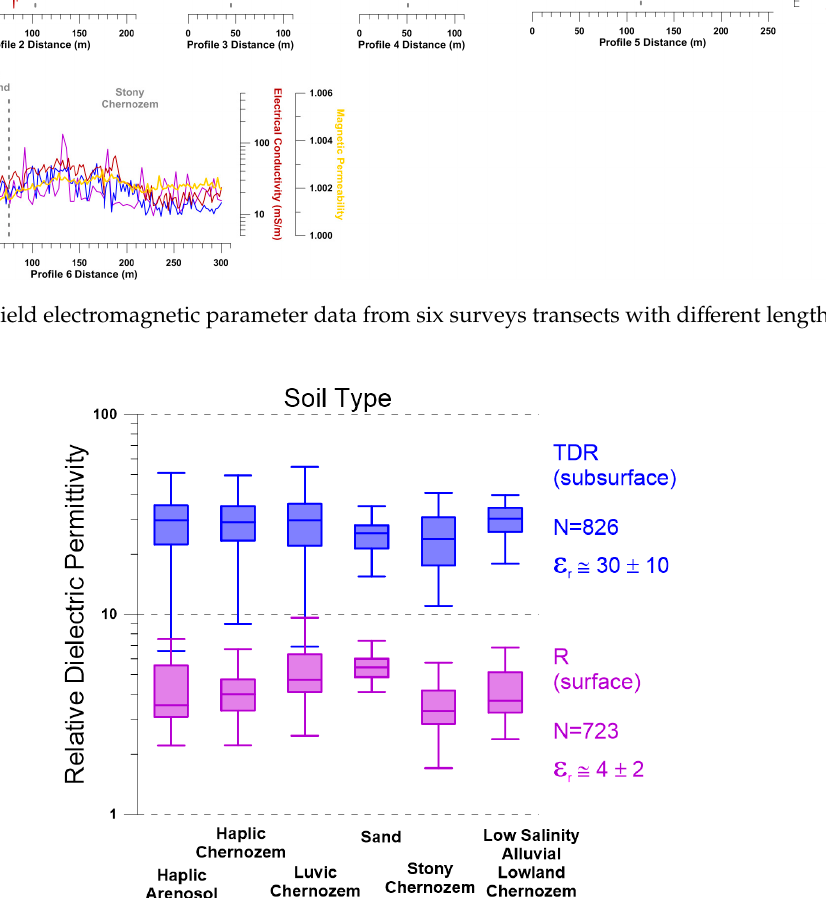
Figure 8. Comparison of the TDR- and R-based dielectric permittivities for typical Donbass soils.